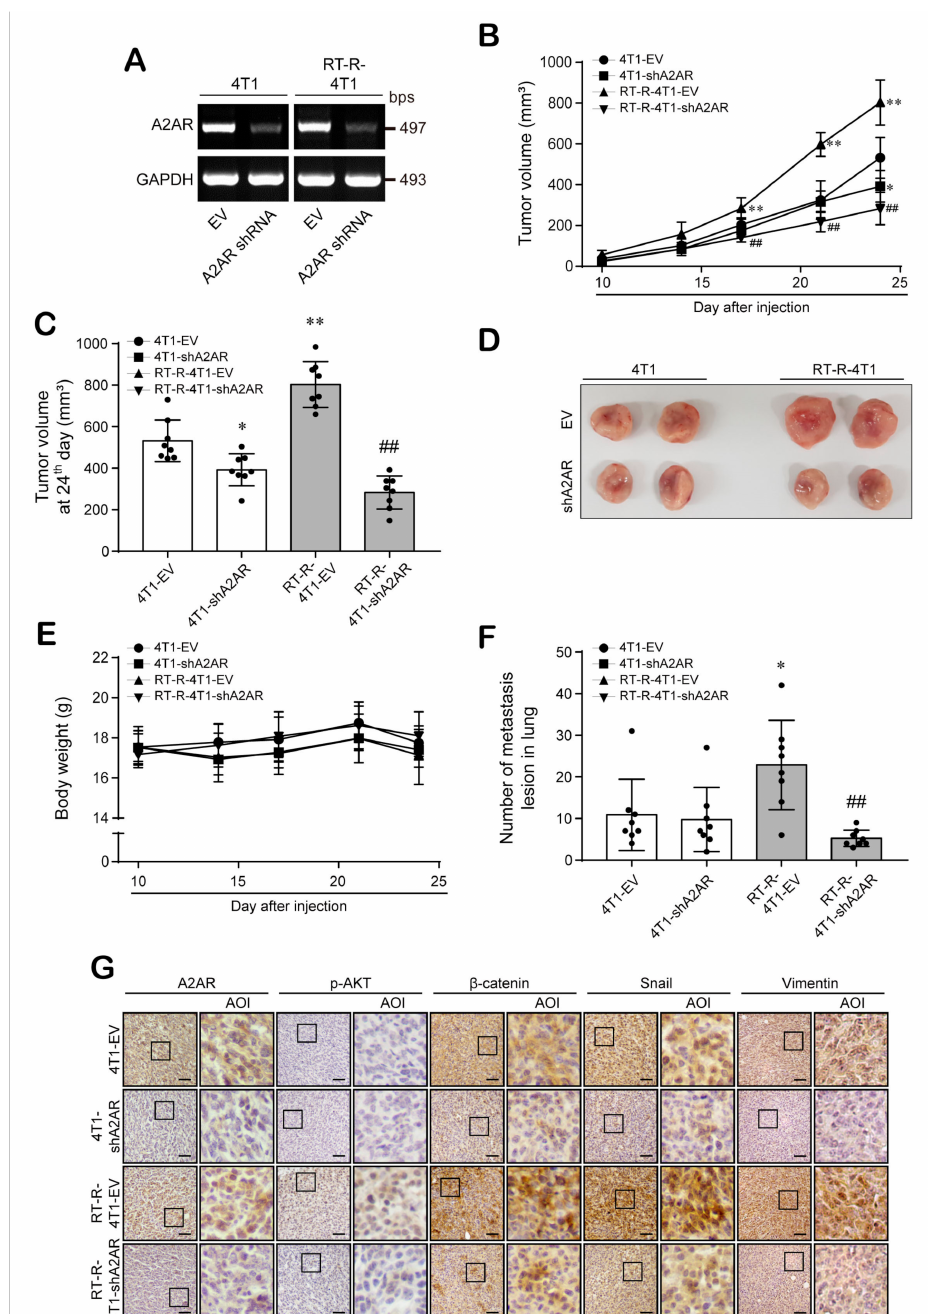
Figure 6. A2AR plays an important role in tumor growth and metastasis in in vivo mouse models. ( A ) Mouse breast cancer cells 4T1 and its RT-R-cells (RT-R-4T1) were stably transfected with empty vector (100 nM; 4T1-EV and RT-R-4T1-EV) or A2AR shRNA (100 nM; 4T1-shA2AR and RT-R-4T1-shA2AR) as described in Section 2. ( B – F ) Balb/c nude mice were divided into 4 groups ( n = 8/each group) and injected subcutaneously (1 × 10 5 cells/100 µ L of serum-free medium). The animals were sacrificed on the 24th day, and the tumors and lung tissues were extracted. Tumor volumes ( B – D ) and body weights ( E ) were measured twice a week during tumor development. The incidence of lung metastasis ( F ) was investigated after sacrifice. * p < 0.05, ** p < 0.01 compared to 4T1-EV; ## p < 0.01 compared to RT-R-4T1-EV. ( G ) Tumor tissue sections were stained with anti-A2AR, anti-p-AKT, anti- β -catenin, anti-Snail, and anti-vimentin antibodies as described in Section 2 (scale bar, 50 µ m), and the sections were counterstained with Mayer’s hematoxylin solution. EV, empty vector; AOI, area of